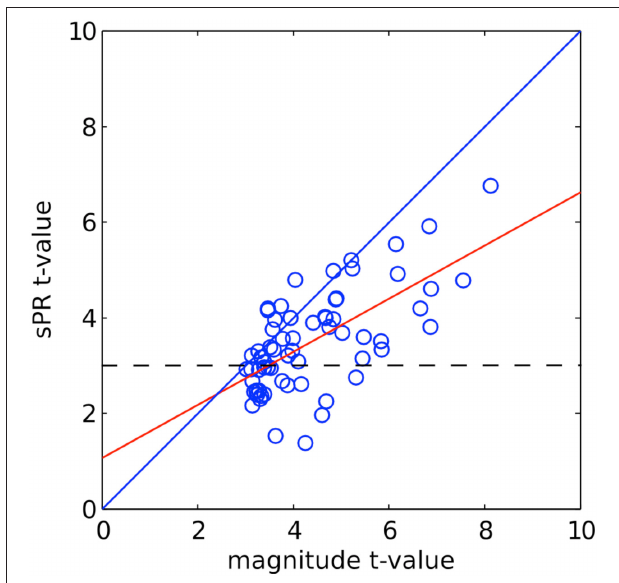
FIGURE 7 | sPR t -values plotted against magnitude t -values for right PPA voxels of one typical subject. The linear fit is shown in red. The dashed line shows the significance level ( t > 3 , p < 0.005) . Many high magnitude t -valued voxels are reduced by large vein suppression but remain significant.